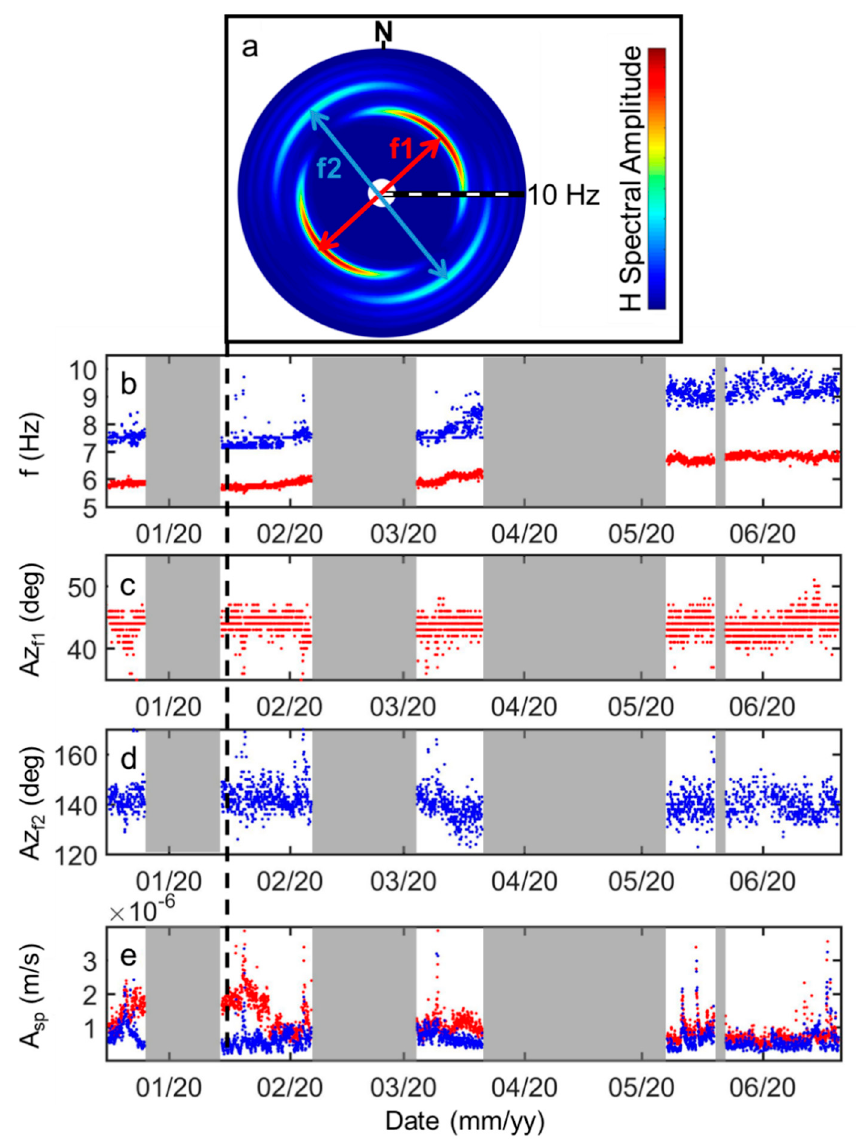
Figure 6. ( a ) Exemplificative polar plot of S2 horizontal spectral components computed on a 1 h noise recording (the location in time in highlighted by the dashed black line in the following panels). ( b – e ) Temporal evolution of ( b ) values, ( c – d ) azimuths (in degrees from N), ( e ) spectral amplitudes of the first two resonance frequencies (f1 in red, f2 in blue) measured on the horizontal plane at S2. No data periods are shaded in gray.